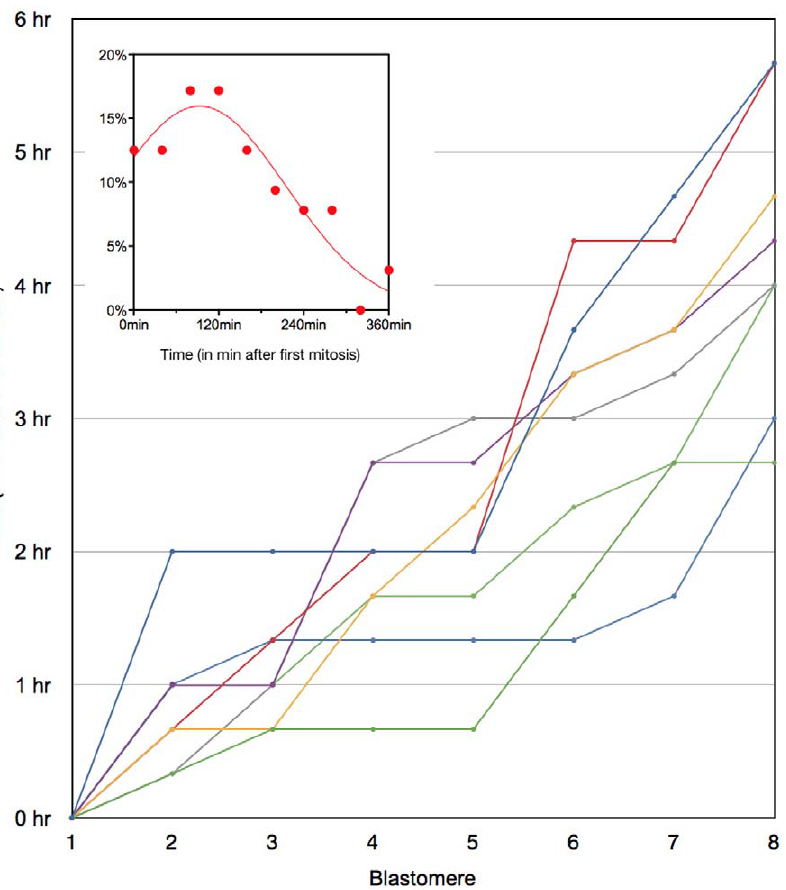
Figure 2. Timing of the eight mitotic divisions in 8-cell stage mouse embryos. Each colour corresponds to a given embryo. Timing of metaphase (Y axis) was used for each blastomere (X axis). Inset: distribution of the timing of metaphase in the population of embryos studied (the Y axis corresponds to the percentage of blastomeres dividing at a given time).